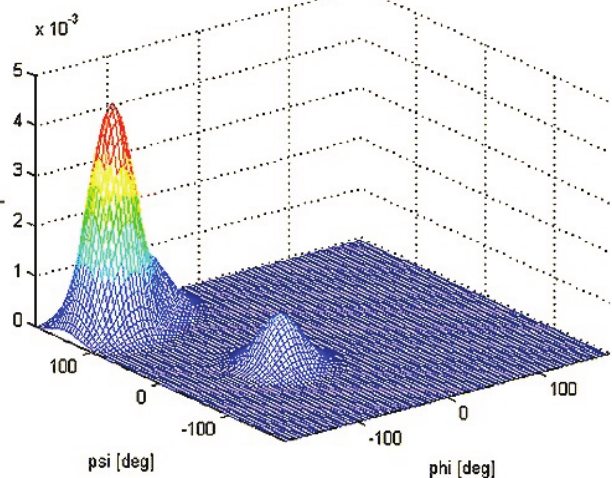
Figure 8. Three-dimensional distribution function in ((cid:4),(cid:5)) space obtained by simulating amide I profiles and NMR coupling constants for trialanine. (Taken from ref. [101] with